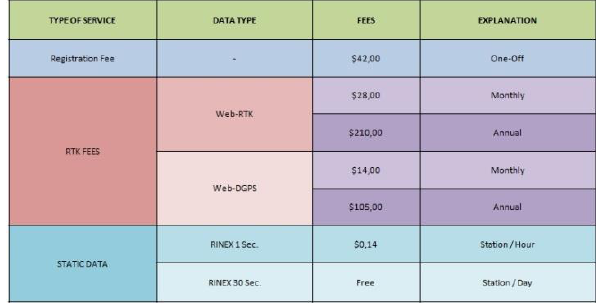
Table 2: CORS-TR System Usage Fees.